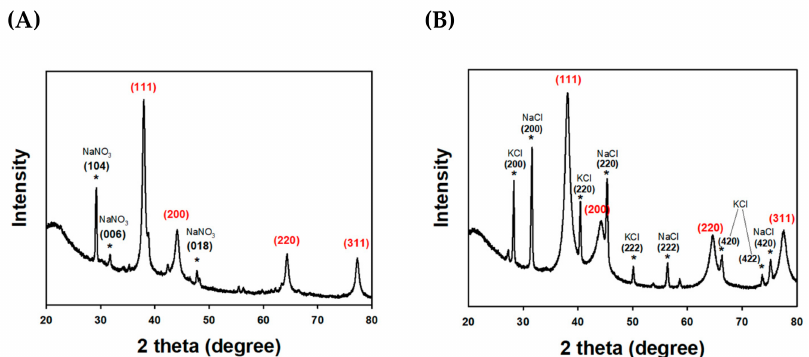
Figure 3. High resolution X-ray di ff raction (HR-XRD) analysis of ( A ) TF-AgNPs and ( B ) TF-AuNPs. The red labeled peaks were from nanoparticles, whereas the asterisk (black labeled peaks) indicated the by-products from the reaction.